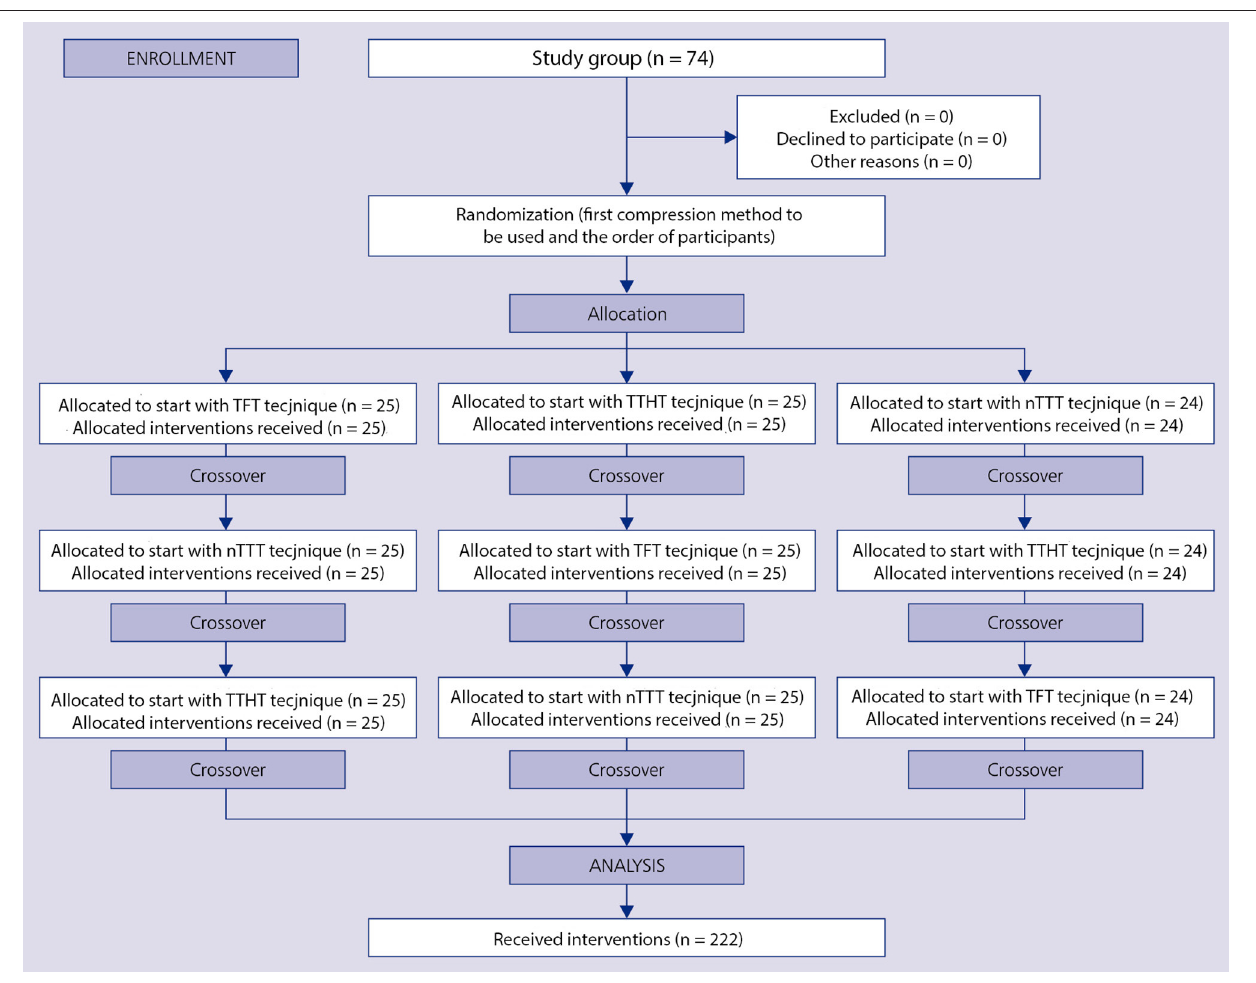
FIGURE 2 | Consolidated Standards of Reporting Trials (CONSORT) flow